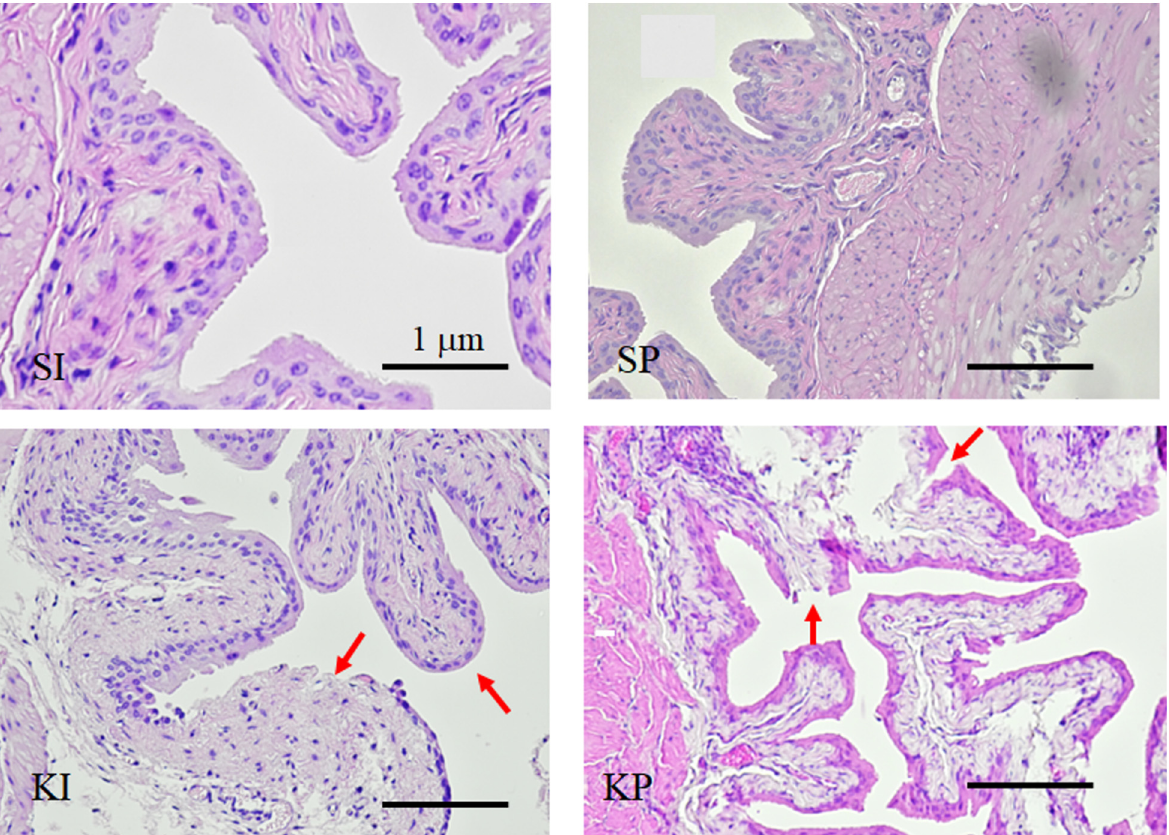
Figure 5. Ketamine inhalation and urodynamic changes. Unstable detrusor contractions (black ar- rows) were recorded in the cystometry curves of KI and KP mice but not in SI and SP mice ( A ). At 3 months, KI and KP mice had significantly lower bladder capacity than SI and SP mice ( p < 0.05) ( B ). The values are expressed in means ± SD. An asterisk indicates a significant difference in Bon- ferroni post-tests following t -test ( p < 0.05).